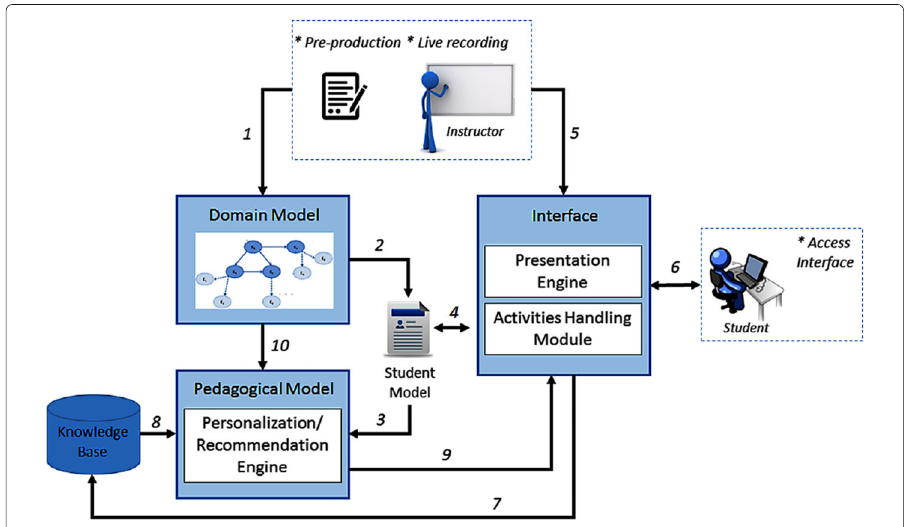
Fig. 2 Architecture overview (Araújo et al.